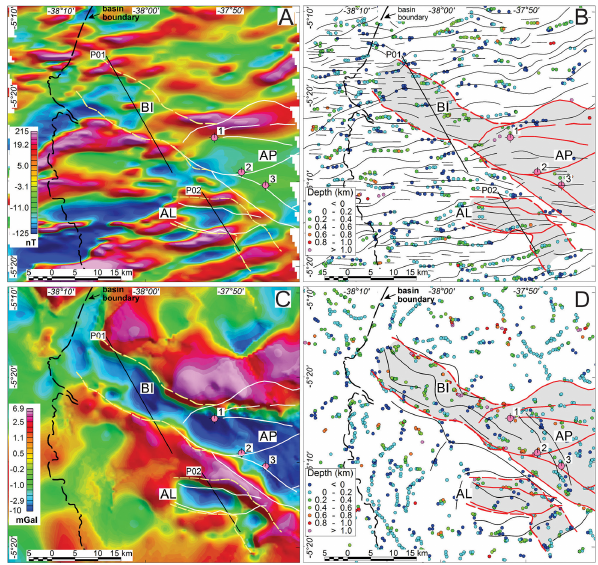
Figure 4. (a) Residual component of the magnetic field reduced to the pole and (b) major magnetic lineaments and Euler solutions; (c) residual gravity anomaly map and (d) major gravity lineaments and Euler solutions. (Grabens (grey zones): BI – Bica; AP – Apodi; and AL – Algodões. Profiles: P01 and P02 (black lines). Exploratory wells: 1, 2, and 3). Solid and dashed white and red traces: rift struc- tures from previous and current studies, respectively.